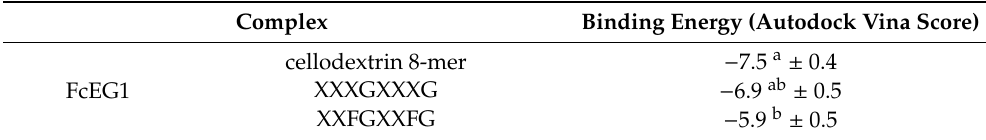
Table 1. A ffi nity energies for the di ff erent protein–ligand